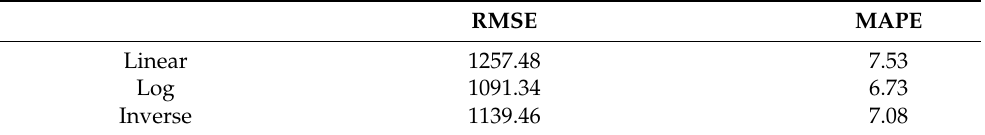
Table 4. Comparison of the linear function model, log function model, and inverse function